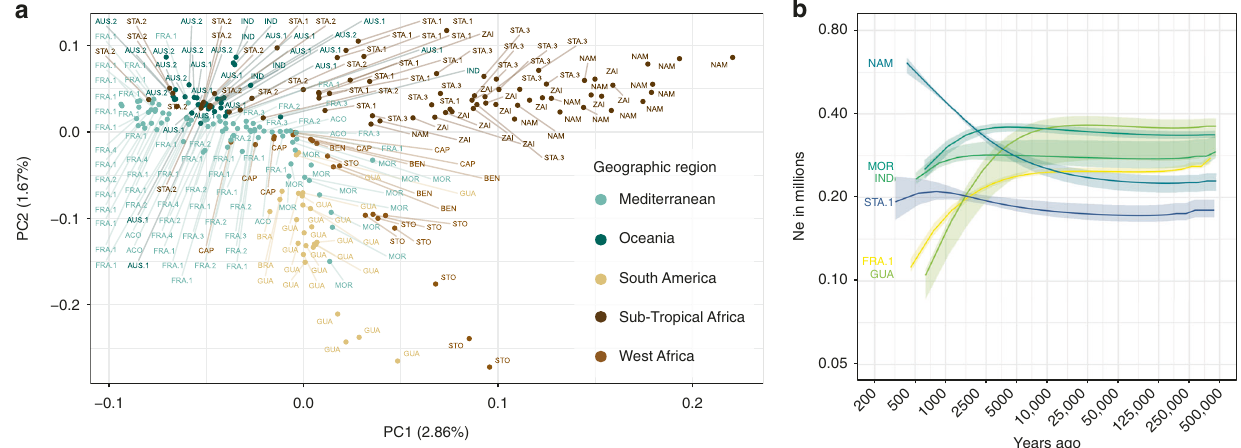
Fig. 2 Global diversity of Haemonchus contortus isolates. a Principal component analysis of genomic diversity. It is based on genotype likelihood inferred from whole-genome sequences of 223 individual males (243,012 variants considered). Samples are coloured by geographic region described in Fig. 1. b MSMC effective population size across time for six isolates. Coloured shaded area represents range of values estimated from a cross-validation procedure with fi ve replicates, computed by omitting one chromosome at a